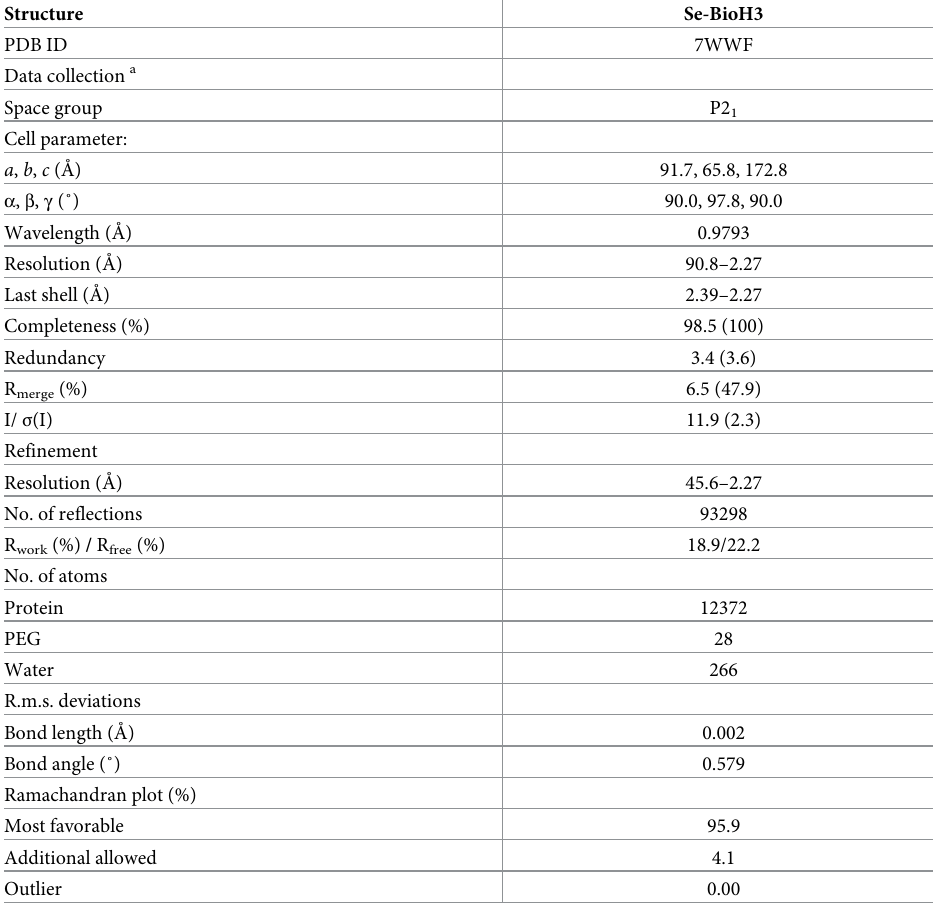
Table 1. Data collection and refinement